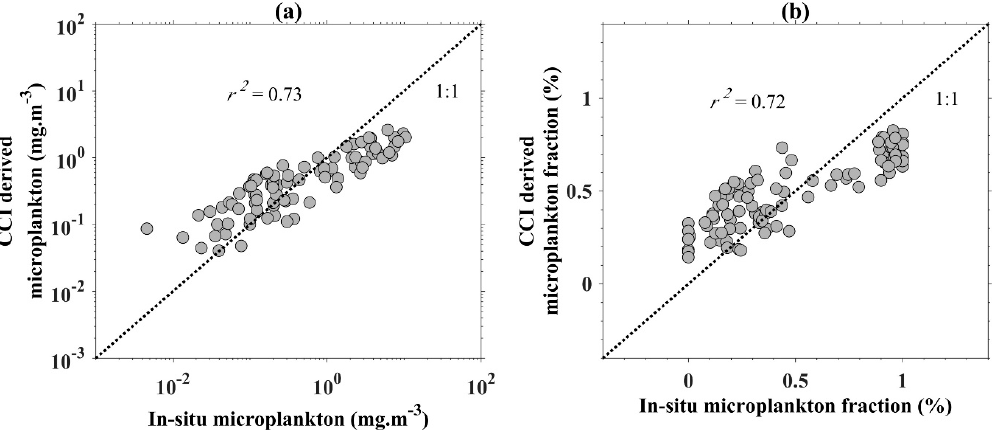
Figure 13. Comparison of CCI-derived ( a ) microphytoplankton concentration, and ( b ) microphytoplankton fraction by model E [25] with in situ